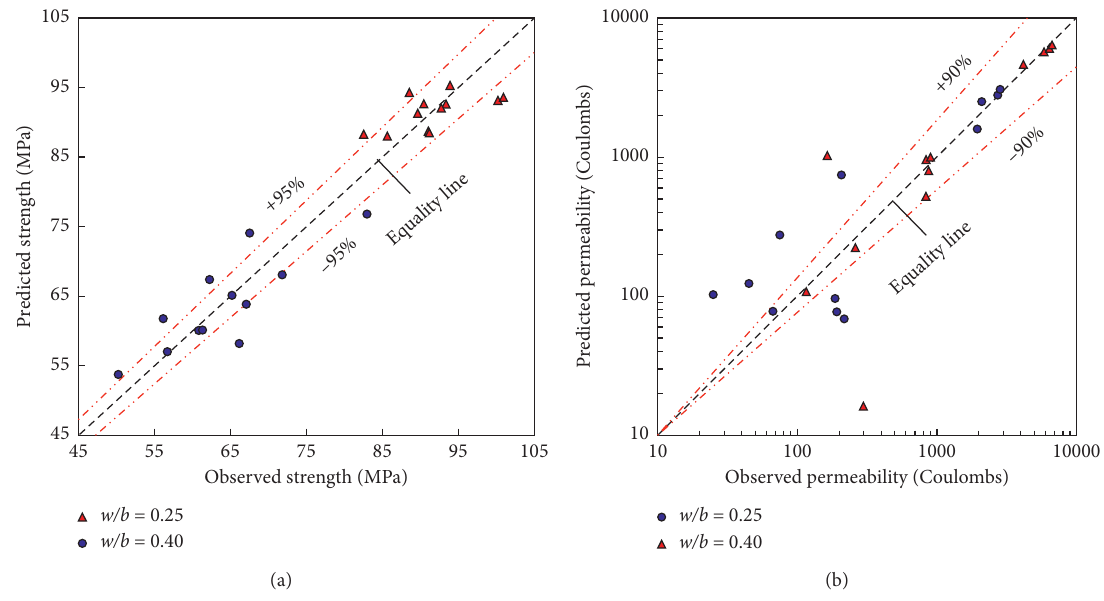
Figure 5: Predicted versus observed isoresponses (SLF regression). (a) Compressive strength. (b)